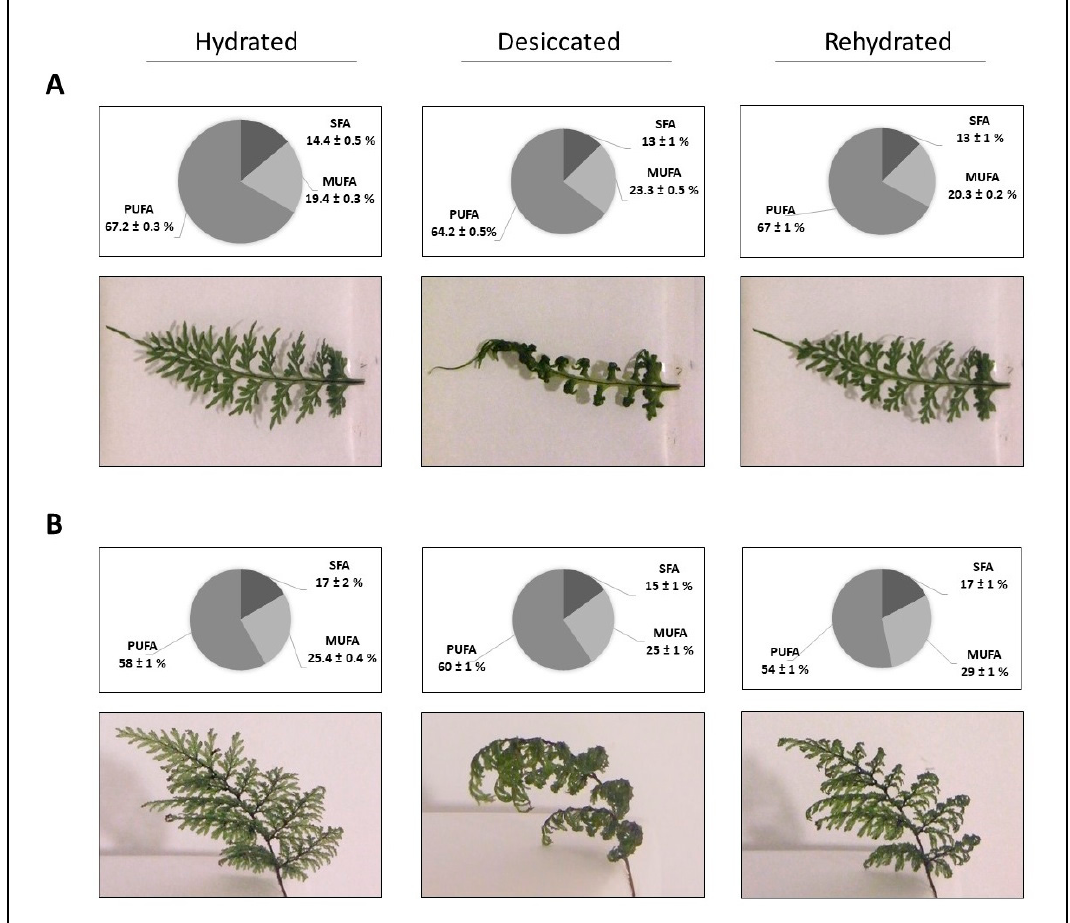
Figure 1. Fatty acid composition (%) and representative images of hydrated, desiccated and rehydrated fronds of two contrasting desiccation-tolerant filmy ferns subjected to a desiccation– rehydration cycle. ( A ) Hymenophyllum caudiculatum , less desiccation tolerant, and ( B ) Hymenophyllum plicatum , more desiccation tolerant. The corresponding values represent the mean of two biological replicates ( ± SE). Fatty acids nomenclature: Polyunsaturated (PUFA), monounsaturated (MUFA) and saturated (SFA).